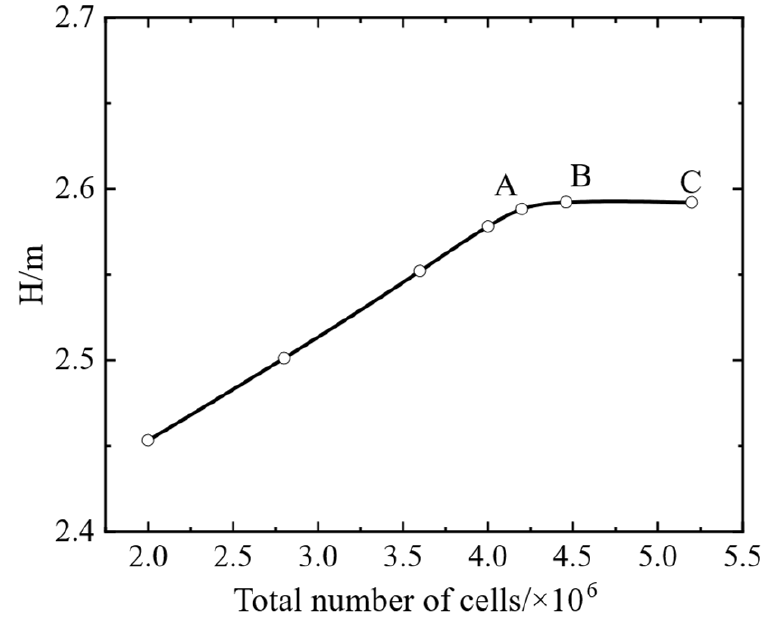
Figure 2 is the grid independence analysis. Different points in the figure represent the selection of different grid numbers for verification. Seven sets of grids with different grid numbers were designed using ICEM software to ensure the accuracy of the calculated values and the rational use of computing resources, and the design water head was selected as the reference to verify the grid independence. When the grid number reaches 4 million, the head’s fluctuation error is already within 1%. Due to factors, such as computing resources, the final selection grid is 4.32 million. The impeller area is 2 million; the front guide vane area is 700,000; the rear guide vane area is 800,000; the inlet section is 600,000, and the outlet section is 300,000.